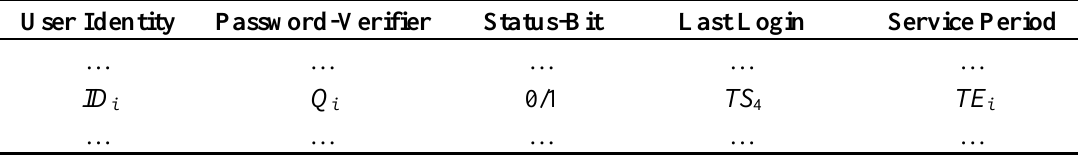
Table 3. The identity table of GWN after finishing the authentication and key agreement